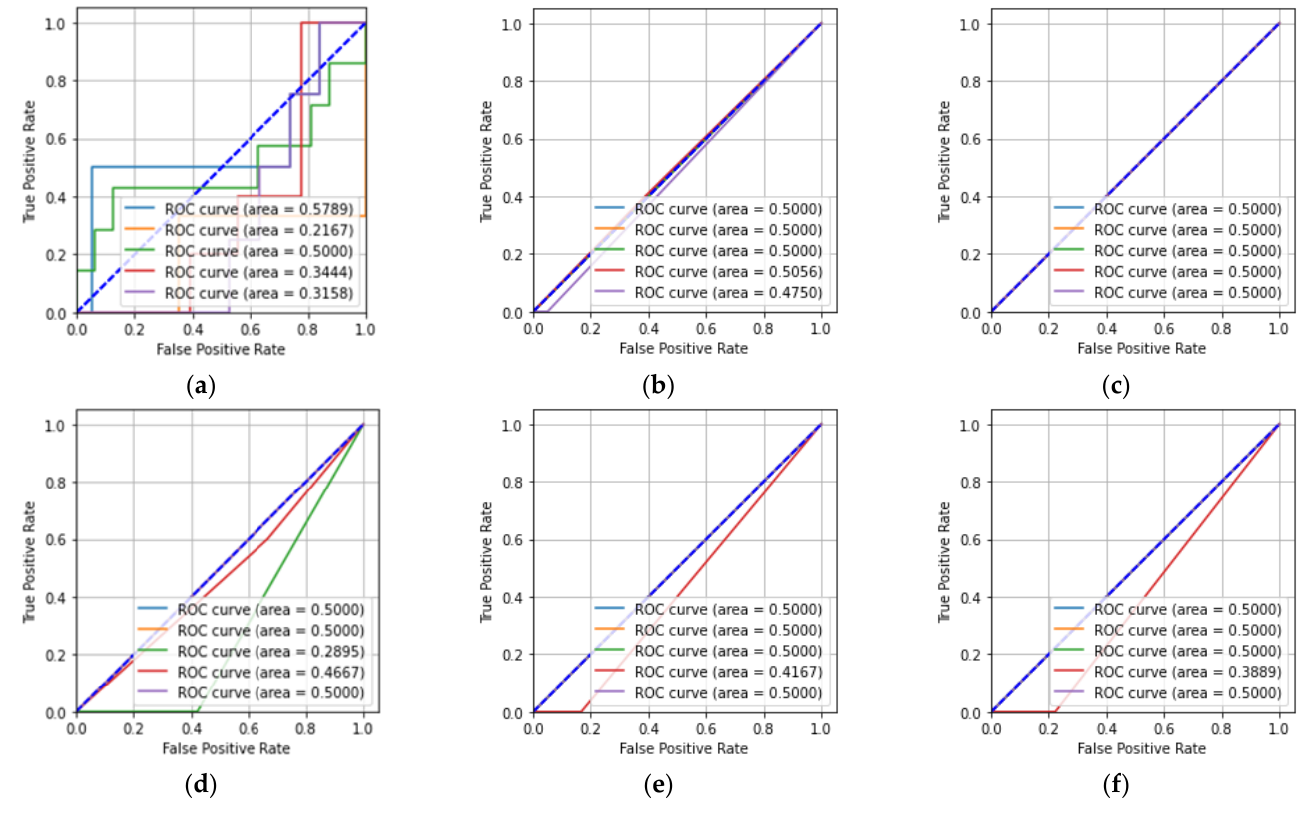
Figure 9. ROCs for the hologram dataset: ( a ) CNN; ( b ) KNN; ( c ) MLP; ( d ) DT; ( e ) RF; ( f ) ET.